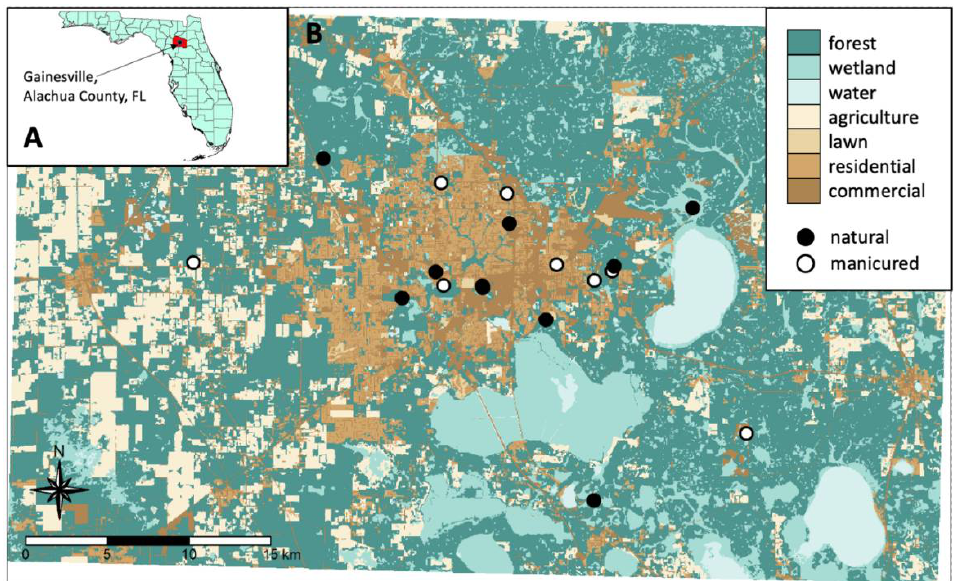
Figure 1. Landcover map showing ( A ) the State of Florida, USA, with Alachua County highlighted in red, and ( B ) the 17 greenspaces sampled in Gainesville, Florida, USA, and the surrounding area.